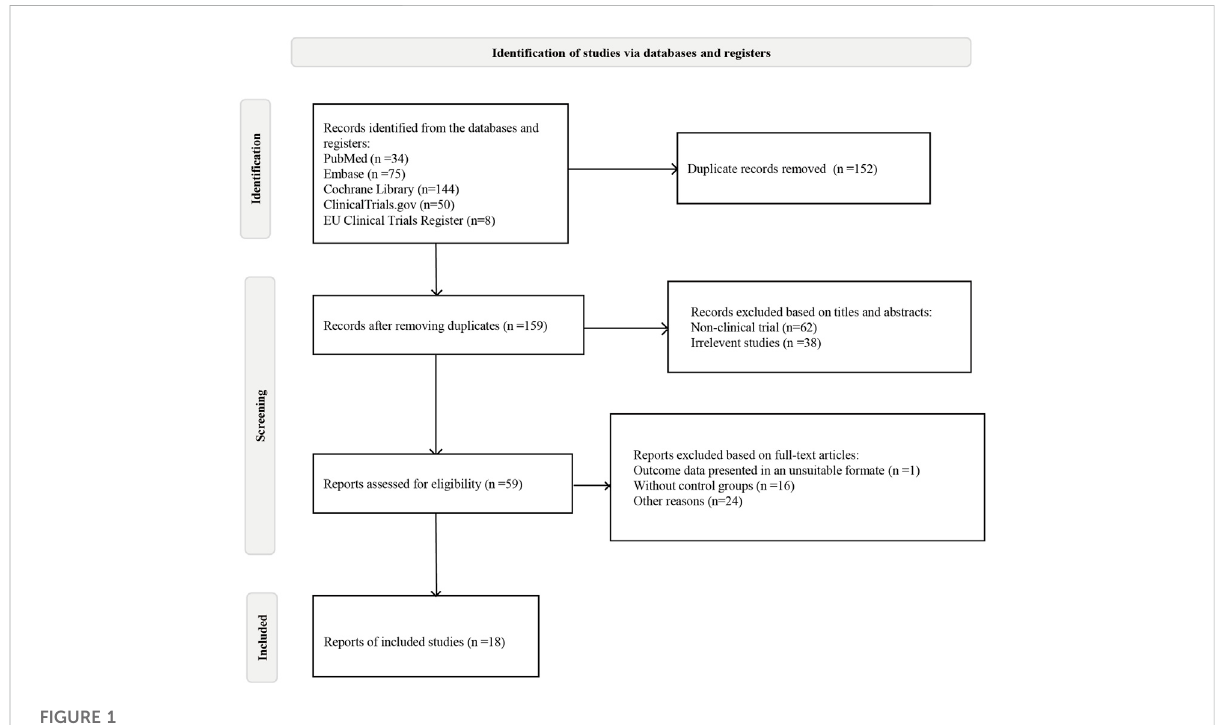
FIGURE 1 Flow chart of eligible